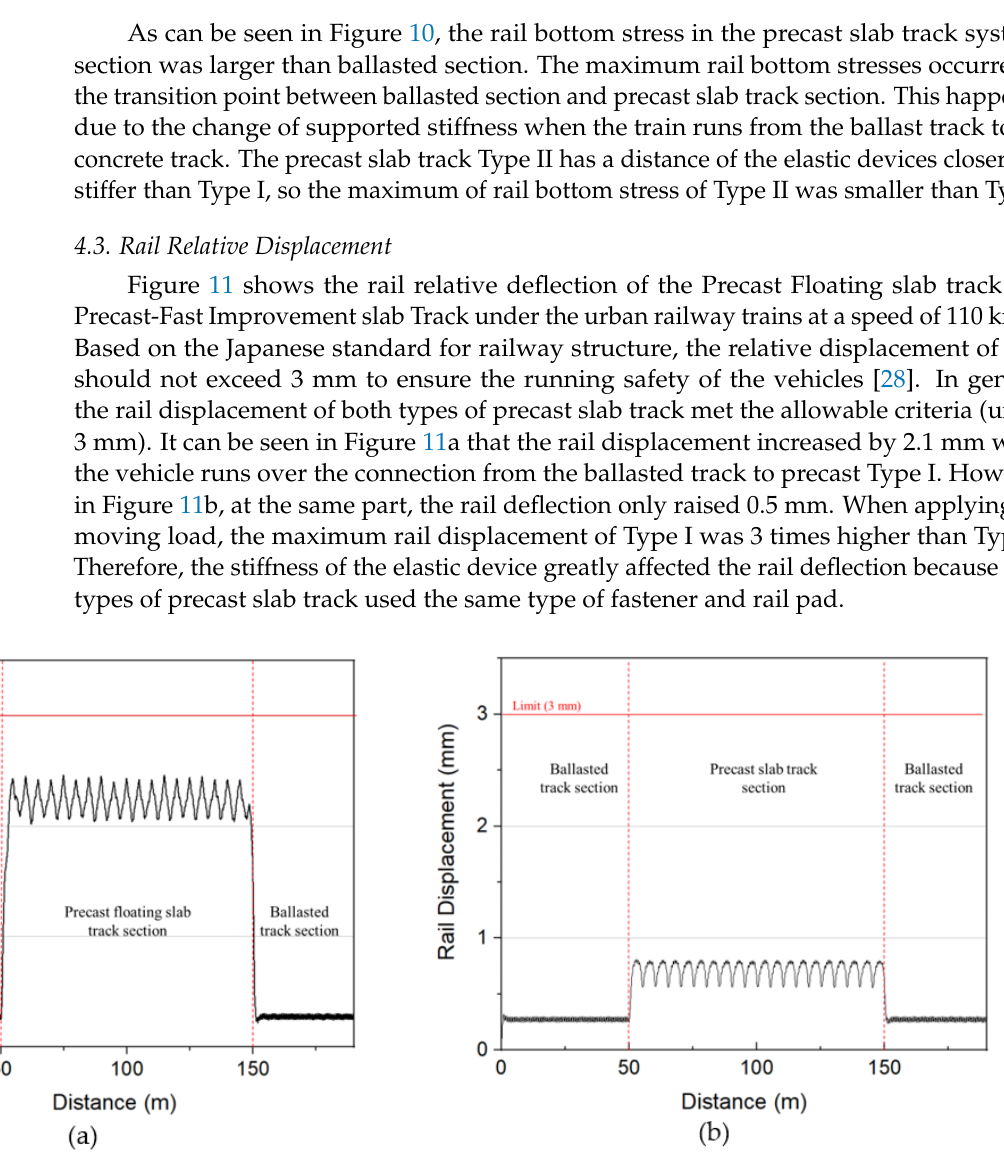
Figure 11. Rail Relative Displacement results: ( a ) Type I, ( b ) Type II.